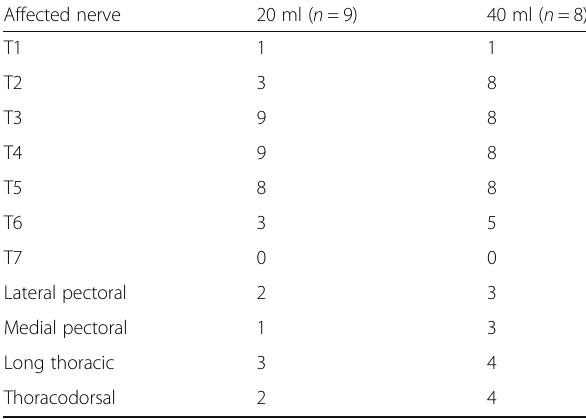
Lateral pectoral Long